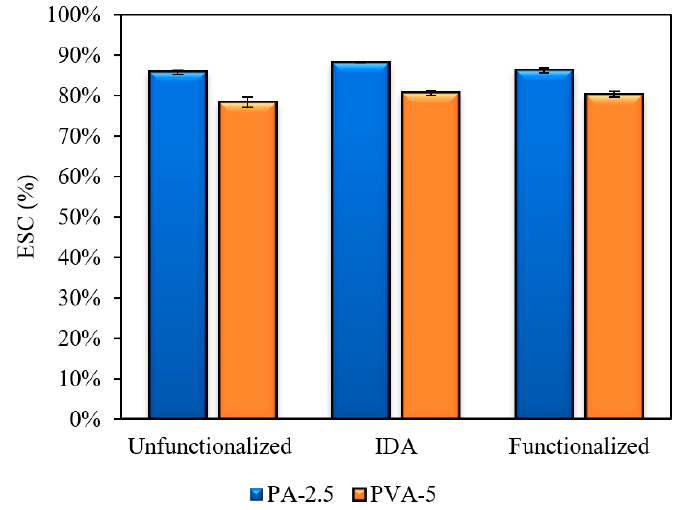
Figure 7. Equilibrium Solution Content (ESC) of control and a ffi nity membranes in water at room temperature.